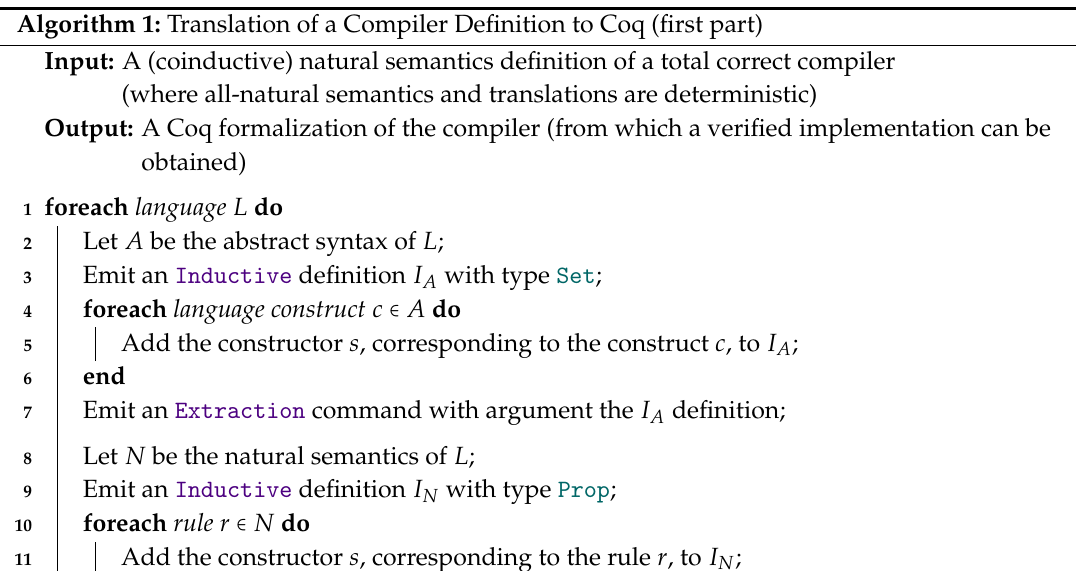
Algorithm 1: Translation of a Compiler Definition to Coq (first